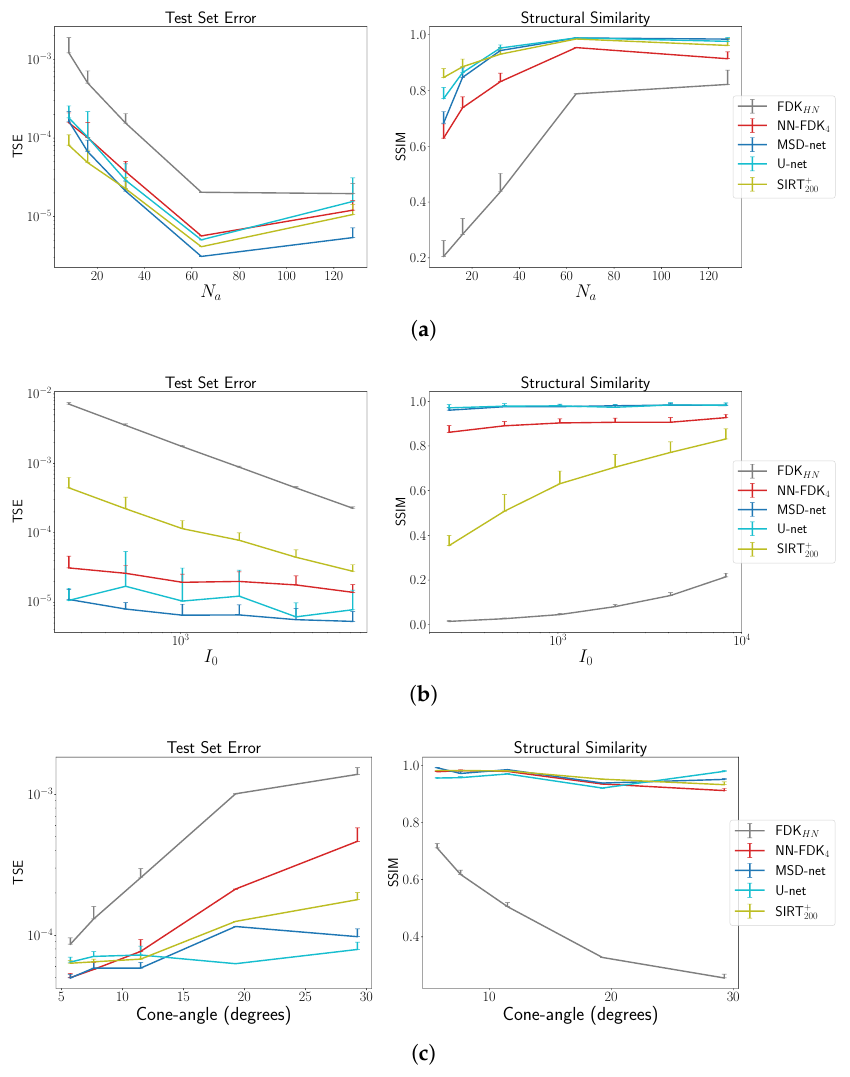
Figure 6. The average and standard deviation of the TSE andstructural similarity index (SSIM). These results are discussed in Section 5.2. For each number of projection angles, the noise level, cone angle and training scenario of one specific network are trained and used to evaluate the 20 reconstruction problems. The NN-FDK reconstruction time is 4-10 times lower than U-net, MSD-net and approximately 40 times lower than SIRT + . ( a ) The average and standard deviation of the TSE and 200 SSIM as a function of number of projection angles N a computed over 20 randomly generated phantoms Fourshape family. ( b ) The average and standard deviation of the TSE and SSIM as a function of the emitted photon count I 0 computed over 20 randomly generated phantoms of the Fourshape family. ( c ) The average and standard deviation of the average TSE and SSIM as a function of the cone angle computed over 20 randomly generated phantoms of the Defrise